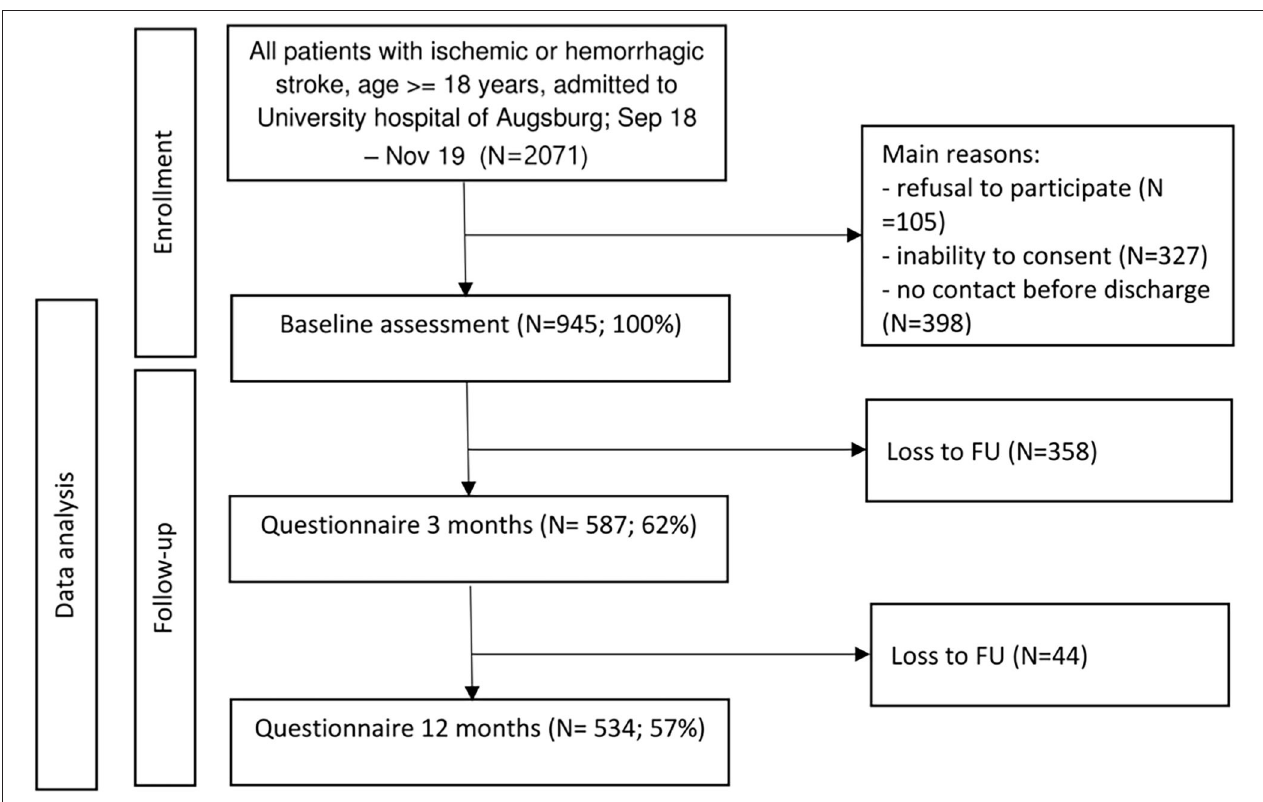
FIGURE 1 | Consort chart of patient enrollment and